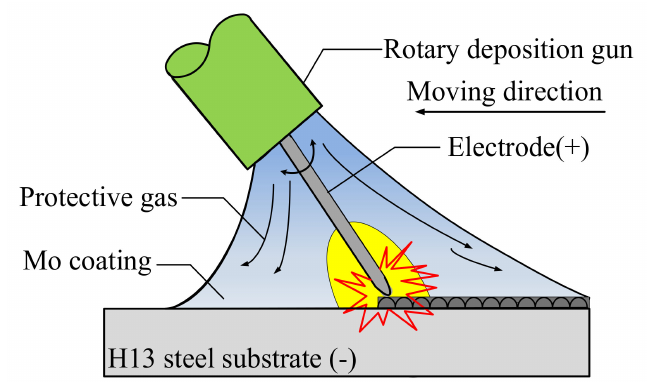
Figure 1. Schematic diagram of preparing Mo coating on H13 steel by